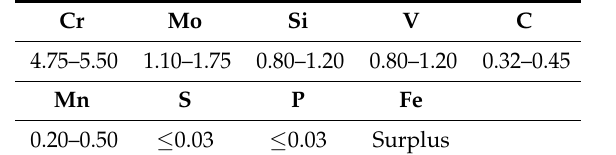
Table 1. H13 Chemical compositions (wt %).